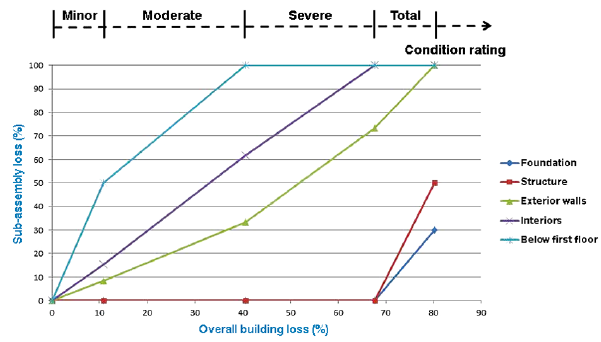
Figure 9. Illustration of condition rating and sub-assembly loss vs. overall building loss for one-storey buildings with timber walls on the basis of 2013 empirical loss data (based on building sub- assembly approach suggested by Hazus-MH Flood Model Techni- cal Manual, FEMA, 2012). The horizontal axis is the overall build- ing loss as a percentage of the building replacement value, and the vertical axis is the sub-assembly loss as a percentage of its own re- placement